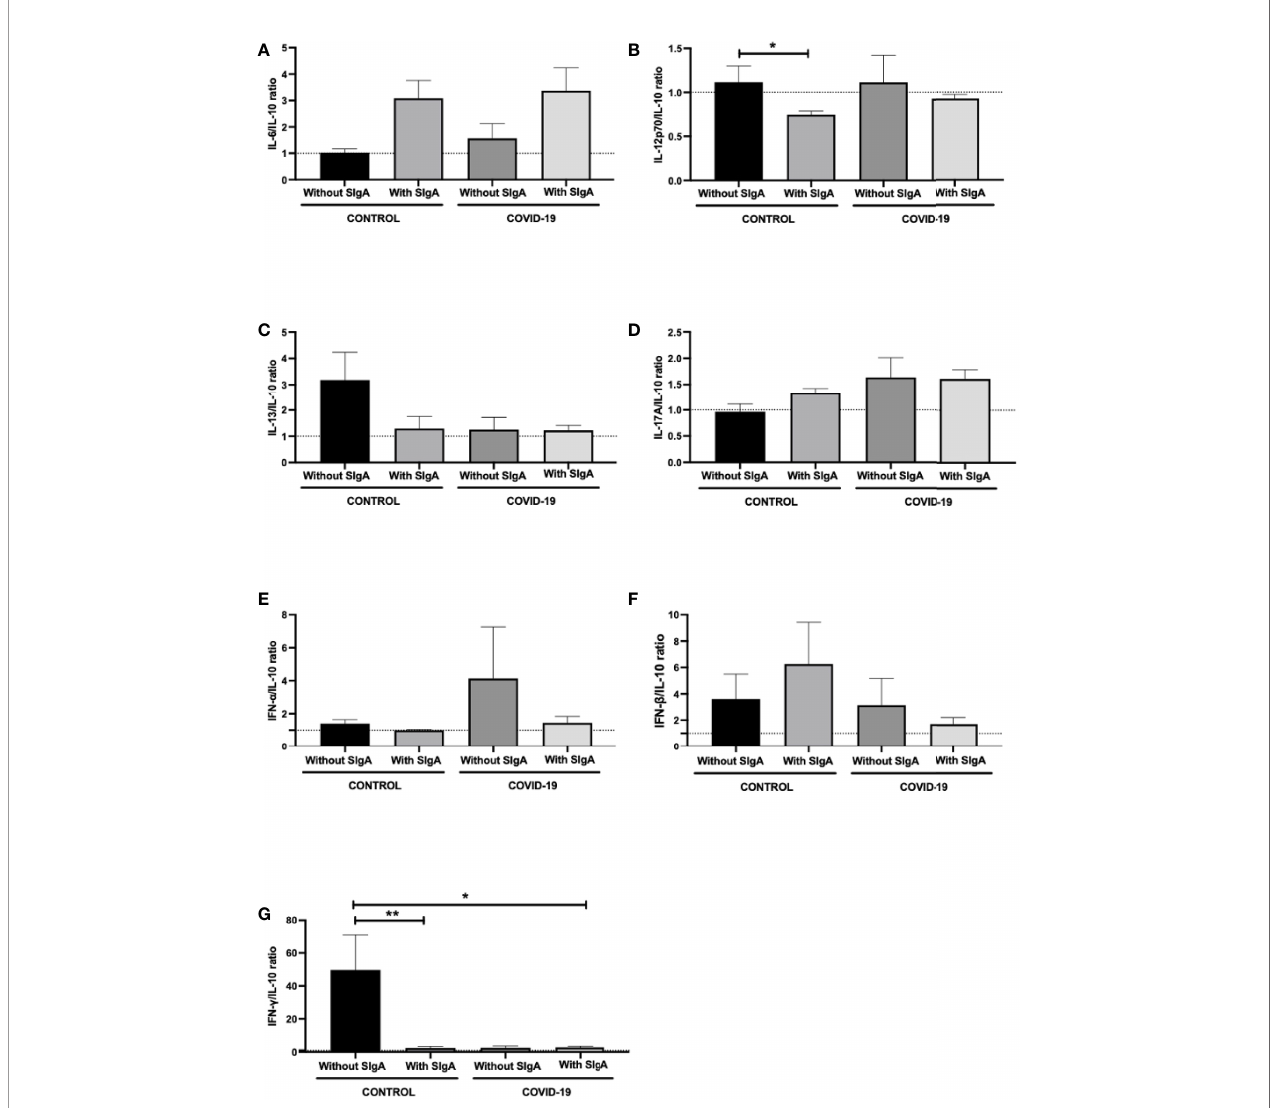
FIGURE 3 | Comparison of the salivary cytokines ratios of IL-6/IL-10 (A) , IL-12p70/IL-10 (B) , IL-13/IL-10 (C) , IL-17/IL-10 (D) , IFN- a /IL-10 (E) , IFN- b /IL-10 (F) , and IFN- g /IL-10 (G) between control without or with SIgA and COVID-19 without or with SIgA group. Values are presented in the median and interquartile range. Statistical analysis: Kruskal Wallis test. The level of signi fi cance was established at 5% (* p < 0.05; ** p <